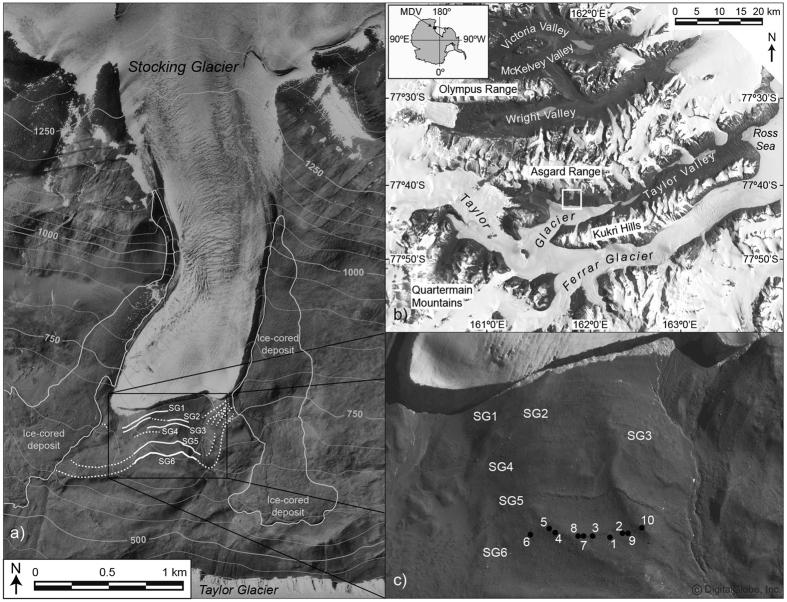
(a) Stocking Glacier and surrounding region on the north wall of Taylor Valley. Drop moraines are traced and labeled in white. Ice-cored lateral deposits are outlines in grey. Southern lateral deposits show geomorphic evidence of flow, but northern deposits (adjacent to present glacier) do not. (b) McMurdo Dry Valleys (MDV) in the Transantarctic Mountains with inset of Antarctica showing location of Dry Valleys. White box indicates location of Stocking Glacier. (c) Close-up view of Stocking Glacier moraines with exposure sample locations; numbers correspond to sample number (1 is DVX-11-01, 2 is DVX-11-02, etc.). Image/data sources: (a) public domain aerial photograph from U.S. Geological Survey, TMA2480-V0120 taken in 1983, courtesy of the Polar Geospatial Center. Topographic contours are from the public domain Lake Vanda Quadrangle (1977, 1:50,000 Topographic Series, U.S. Geological Survey, Reston, VA), rectified with the aerial photograph in ArcMap 10, www.esri.com. (b) Public domain Landsat7 imagery courtesy of NASA Goddard Space Flight Center and U.S. Geological Survey. (c) This figure is not covered by the CC BY license. GeoEye-1 Satellite image ©2013 DigitalGlobe. All Rights Reserved. Courtesy of the Polar Geospatial Center. Used with permission. All manuscript figures were created in Adobe Illustrator CC 2015, www.adobe.com/illustrator.